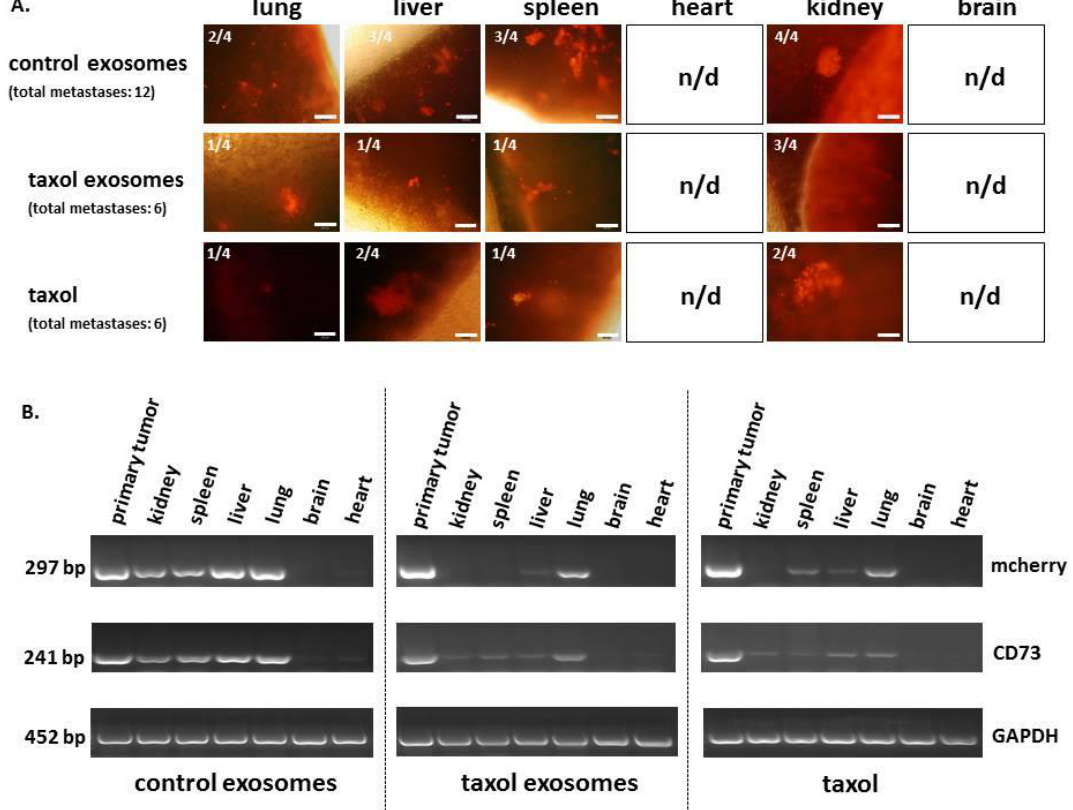
Figure 7. (A ) Formation of distant organ metastases was detected by appearance of mcherry fluorescence in thin sections of organ tissues. Exemplary phase contrast/luorescence microscopy overlay pictures of organ metastases are documented. Moreover, the total number of organs with distal metastatic tumor cells is displayed (n.d. = not detectable). Bars represent 100 µm. ( B ) PCR analysis of primary tumor and organ tissue aliquots was performed to substantiate detection of metastatic MDA-hyb1 cancer cells by the presence of mcherry and CD73 transcripts. Unaltered GAPDH mRNAs served as loading control.